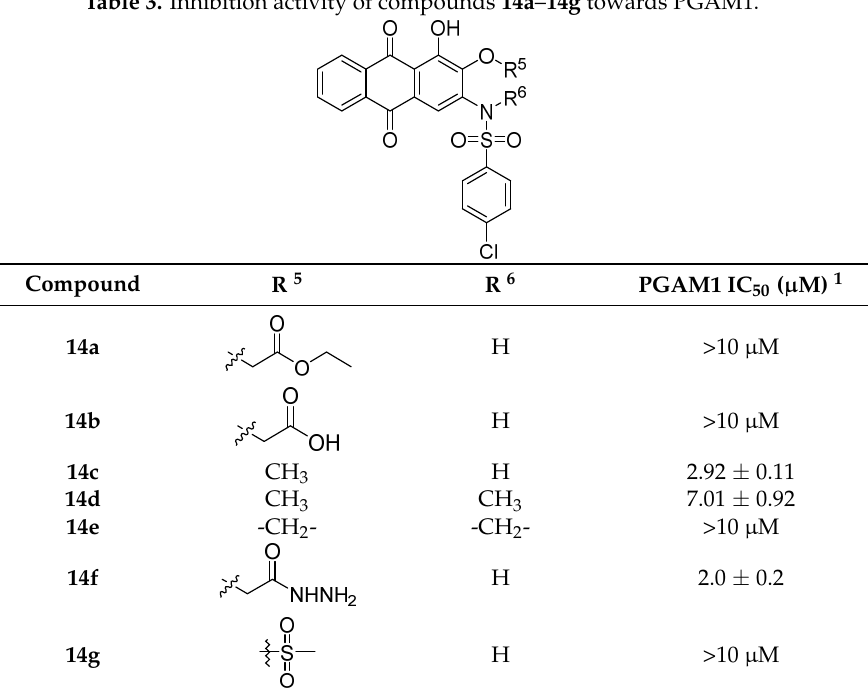
Table 3. Inhibition activity of compounds 14a – 14g towards PGAM1.